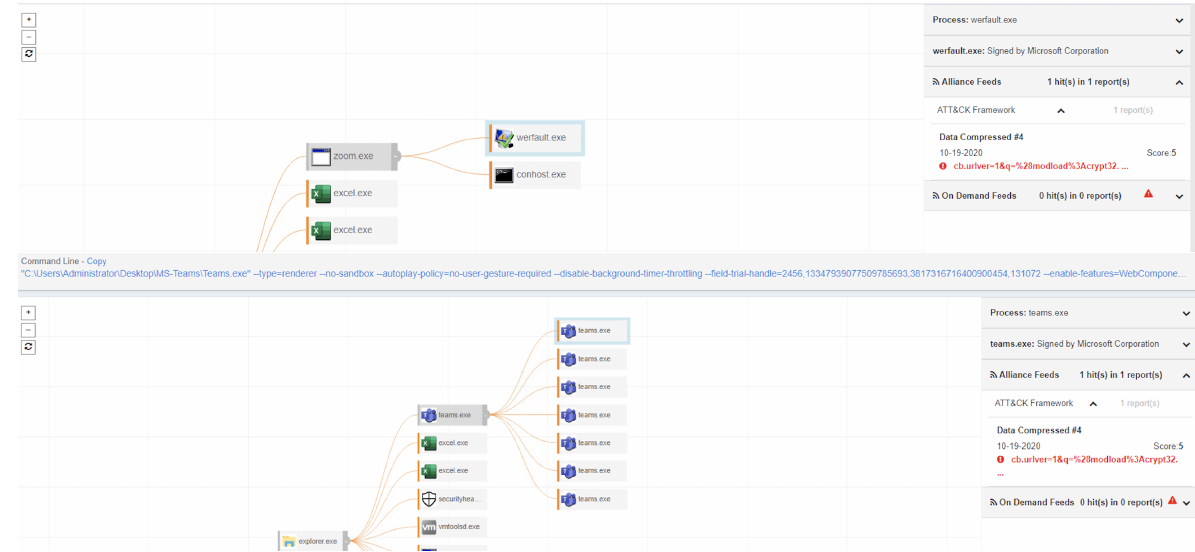
Figure 7. The findings of Carbon Black for the EXE and DLL attack